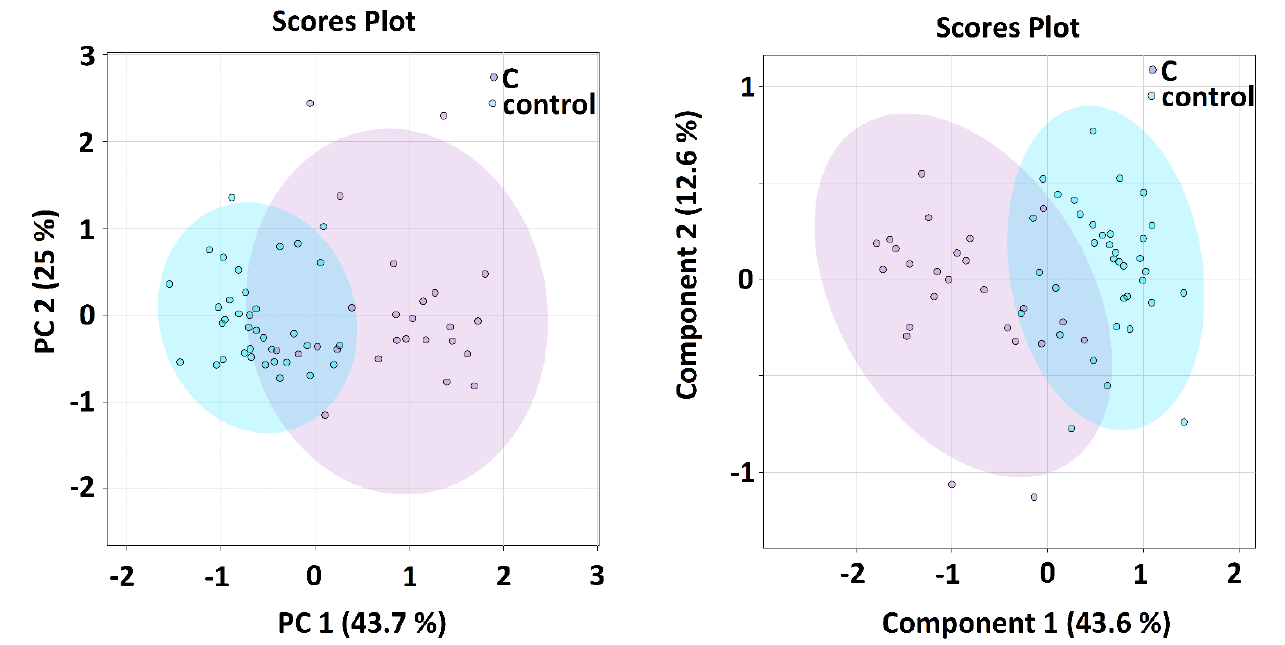
Figure 1. PCA ( left ) and PLS – DA ( right ) analysis of patients with COVID – 19 disease at three vari- ous sampling times in patients and controls, the relative concentrations of metabolites in blood plasma were used as input variables.